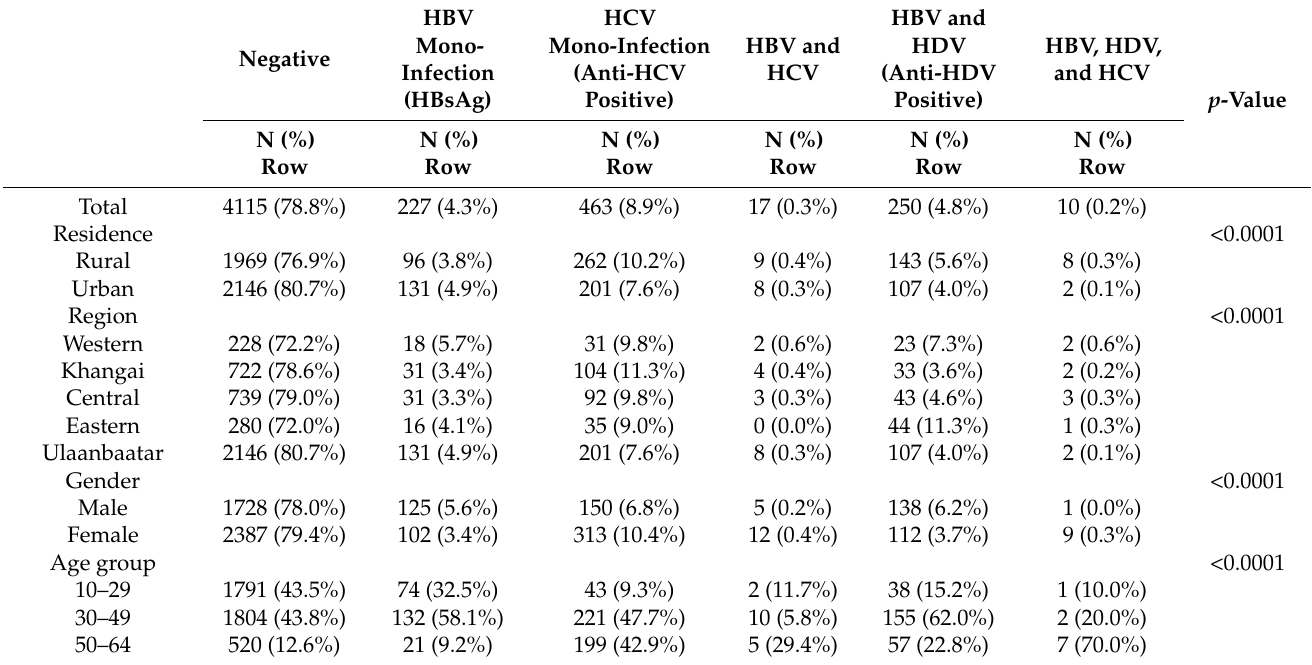
Table 1. Distribution of hepatitis serological antigens in the study